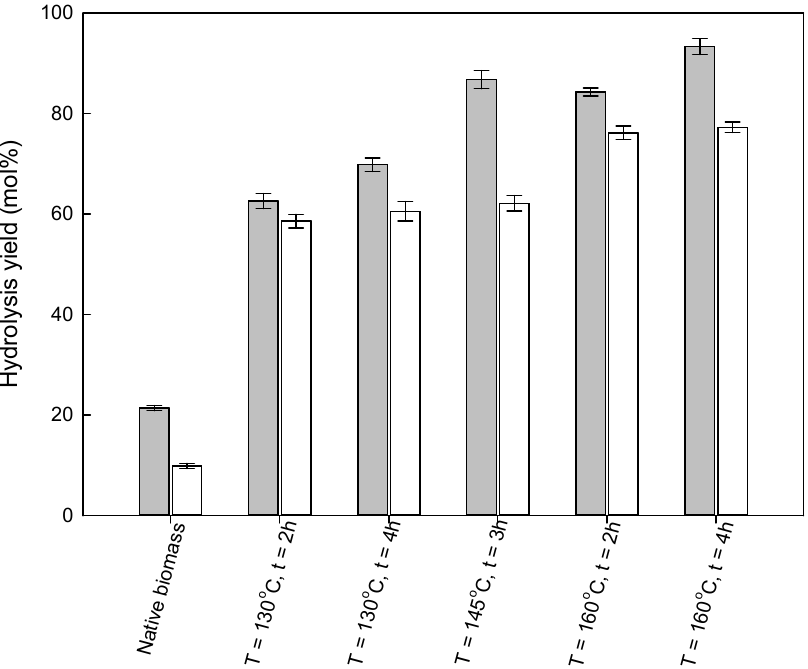
Figure 5. Glucan to glucose (grey bar) and xylan to xylose saccharification (white bar) yields, over 72 h of enzymatic hydrolysis time of wheat straw pre-treated solids, as a function of the pre-treatment conditions. The enzymatic hydrolysis yields for native wheat straw are presented for comparison.